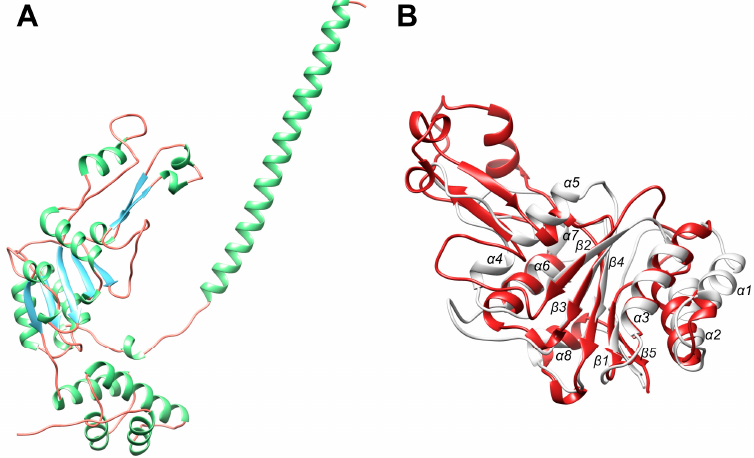
Figure 10. Topology of the A domain of Bs LonBA. ( A ) Model of the A domain of Bs LonBA based on structure prediction with AlphaFold2. Colors: α -Helices green, β -strands blue, irregular structure red. ( B ) Superposition of the core of the model of the A domain of Bs LonBA shown in panel A (red) and the AAA + module of the Ec LonA (6u5z, white). 2.7. Comparison of the Functionally Important Elements in the AAA + Module of BsLonBA with Their Counterparts in LonA and LonB